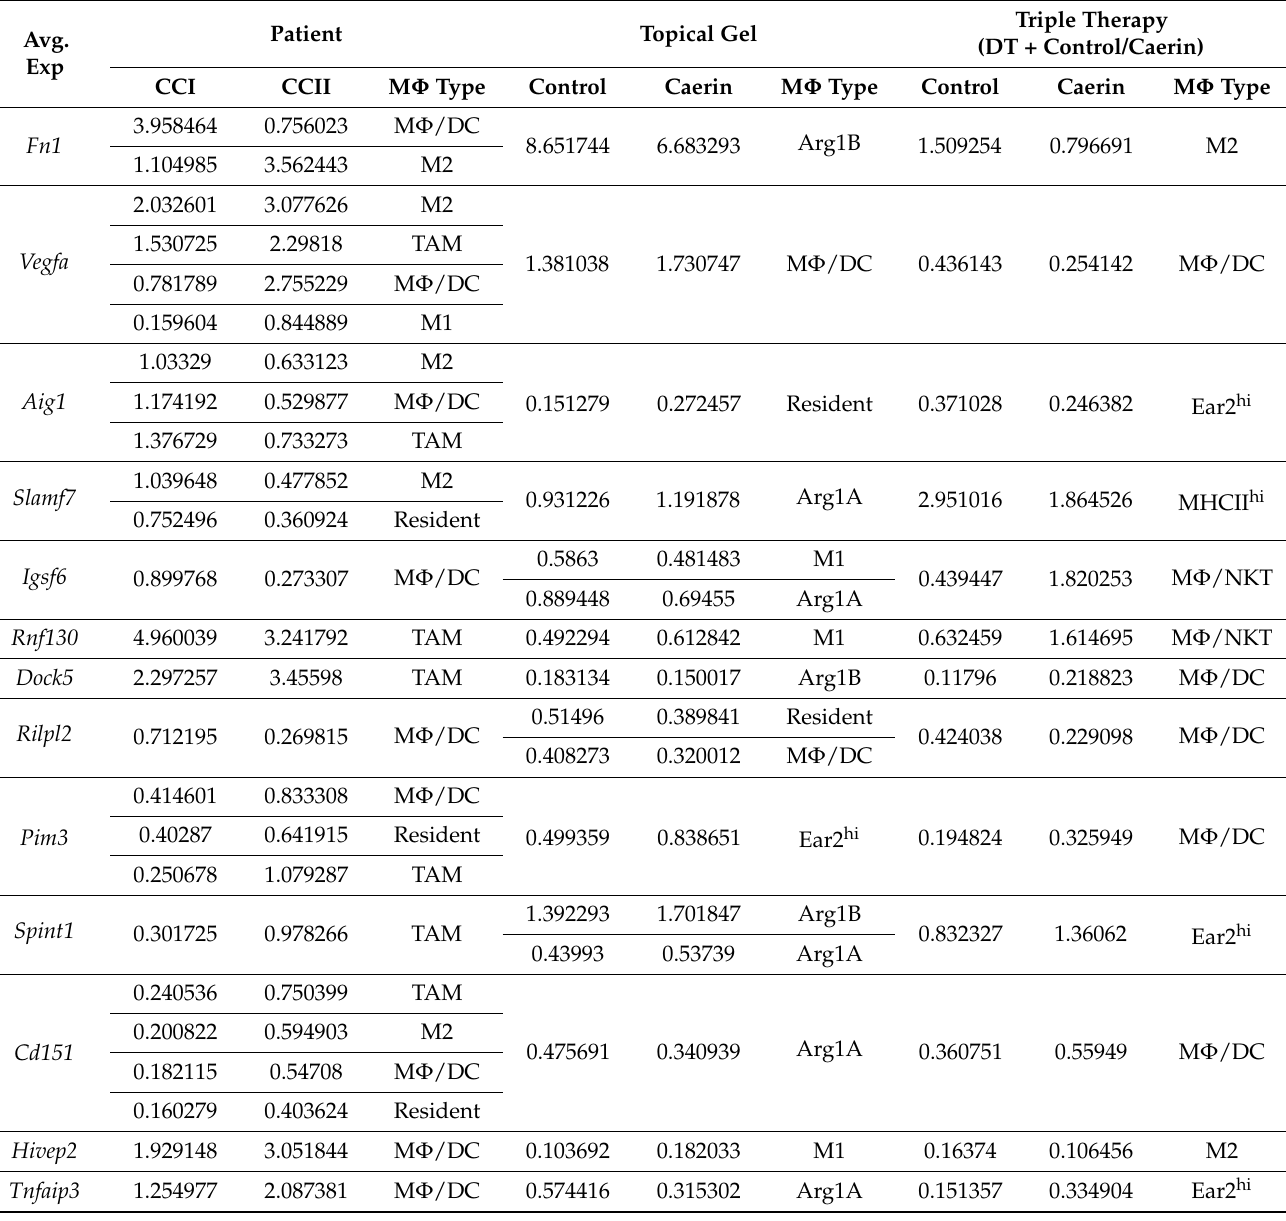
Table 2. The list of genes differentially expressed between the M Φ s of the CCI and CCII groups, that were also significantly regulated in the M Φ s of the caerin groups of topical gel and triple therapy treatments